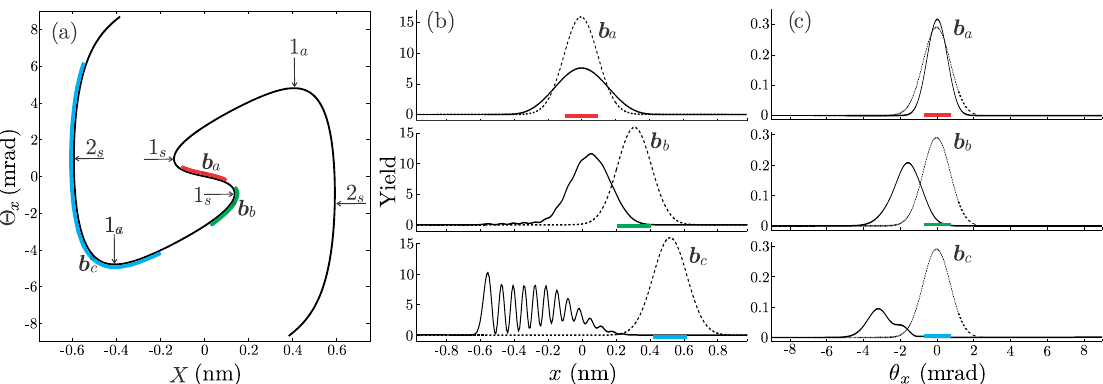
Figure 6. ( a ) Rainbow diagram of 1-MeV protons transmitted through 200-nm long SWCNT (14,4). Arrows show positions of the classical rainbow points. Motion of the wave packets having impact parameters b a = (0,0), b b = (0.31, 0), and b c = (0.52, 0) nm, respectively, in the: ( b ) spatial, and ( c ) angular representations. Initial wave packets are shown by the dashed lines while final wave functions are shown by the solid lines. Intervals containing trajectories giving dominant contribution to wave packets are denoted by the thick red, green, and blue lines,